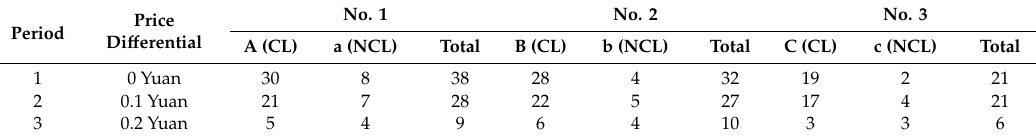
Note: CL = carbon-labeled, NCL =